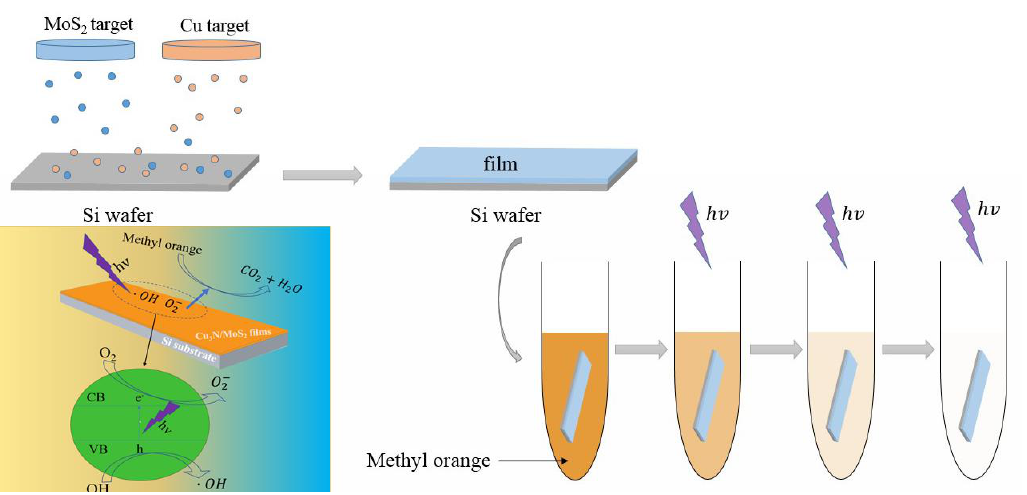
Figure 7. Scheme of photocatalytic degradation of methyl orange solution by Cu 3 N/MoS 2 composite films.